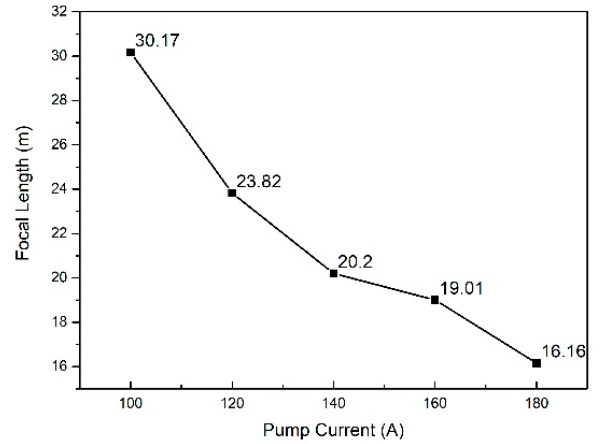
Figure 3. The relationship between pump current and the focal length of the gain module.